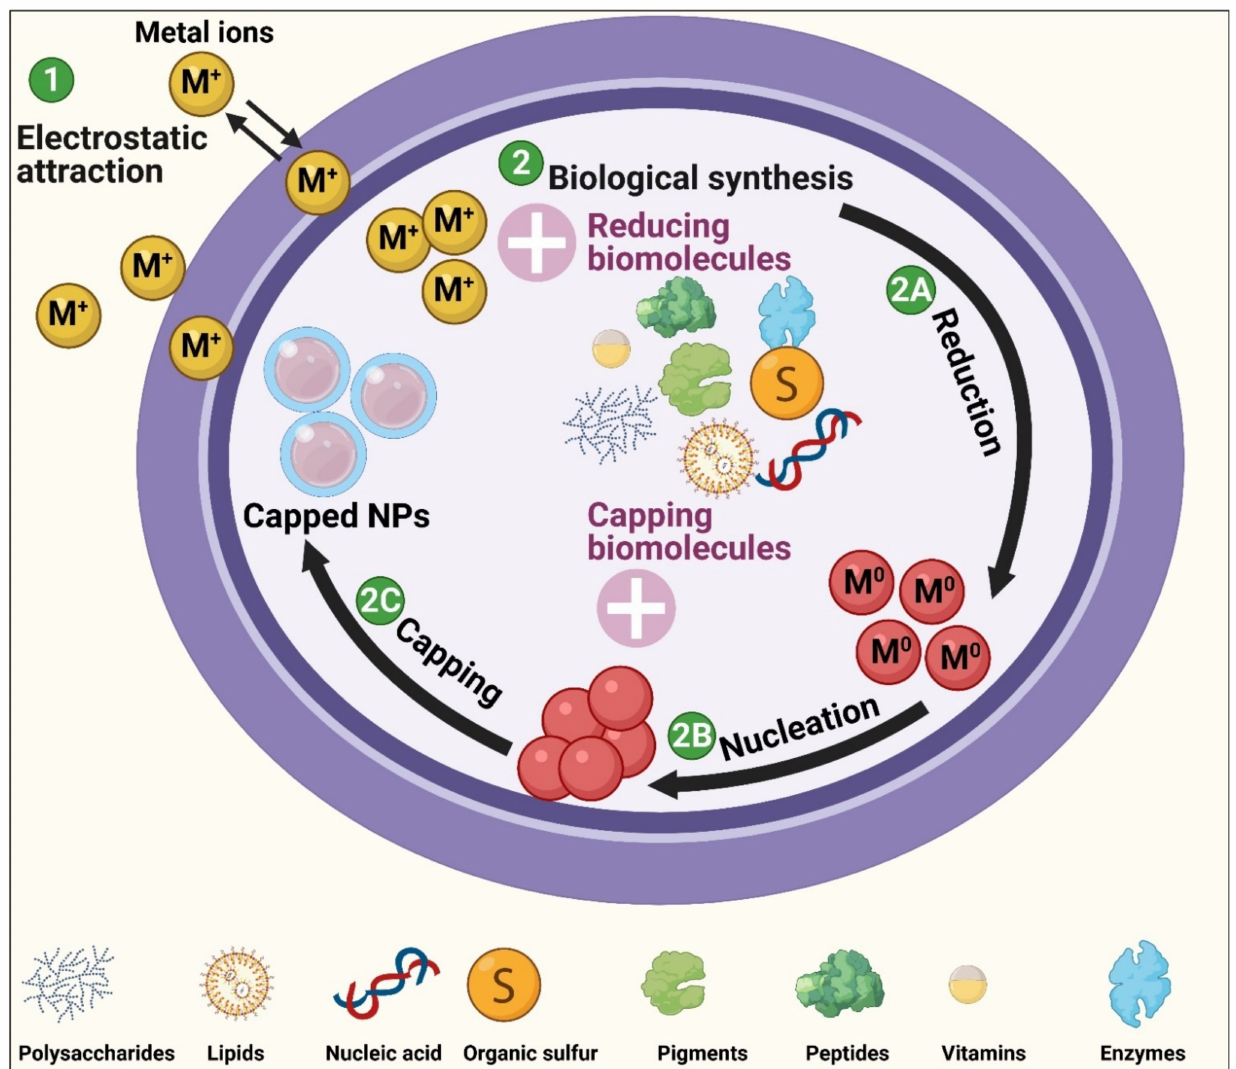
Figure 7. The potential mechanism of biological synthesis of